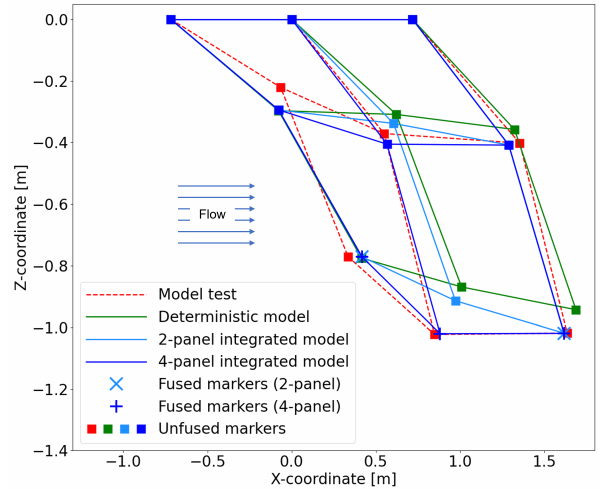
Figure 12: Cage deformation from the model test, de- terministic model, and integrated model (Case 2: flow speed = 0.56 m/s).